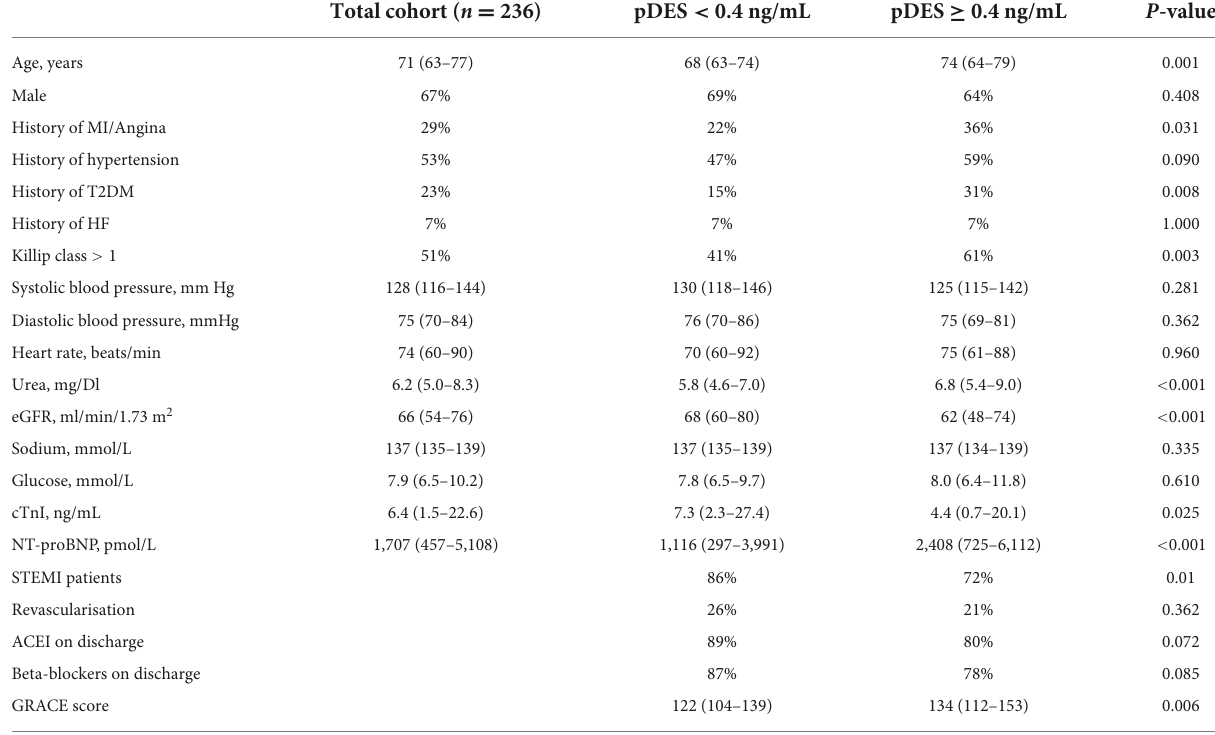
TABLE 2 Study demographics for the total cohort and split by median plasma desmosine (pDES) levels. Total cohort ( n = 236)